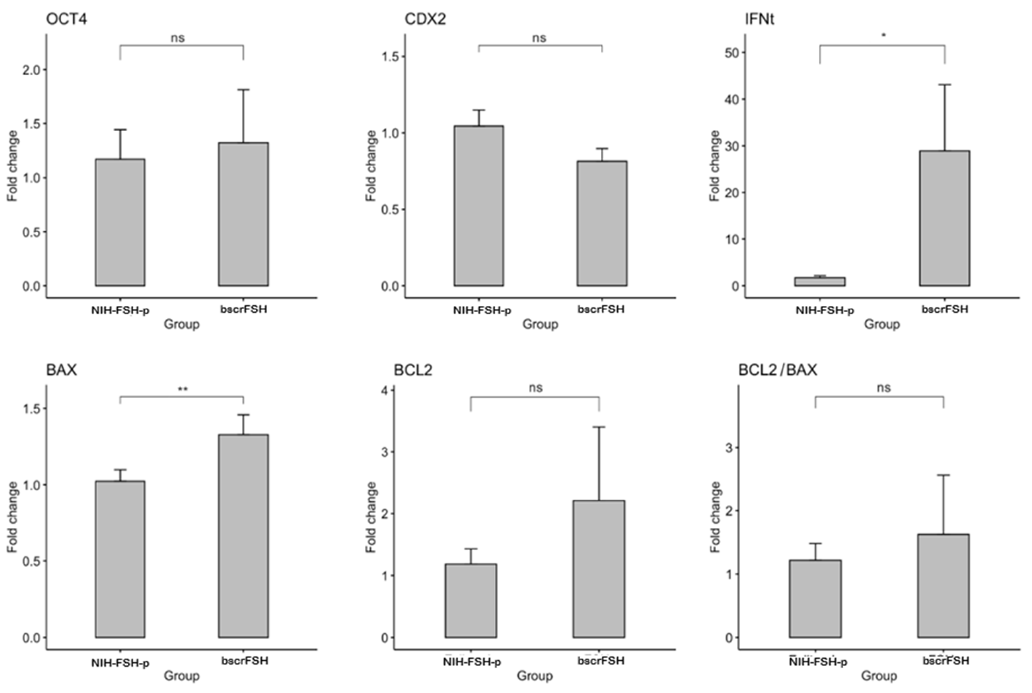
Figure 4. Gene expression analysis in in vivo produced bovine blastocysts by using a superovulation protocol that includes the standard pig pituitary-derived FSH (NIH-FSH-p) or extra-long-acting single-chain bovine follicle-stimulating hormone (bscrFSH). Bars represent the Fold Change in bscrFSH relative to NIH-FSH-p group. *, ** indicate significant differences between groups ( p < 0.01 and p < 0.05, respectively). ns: non-significant.